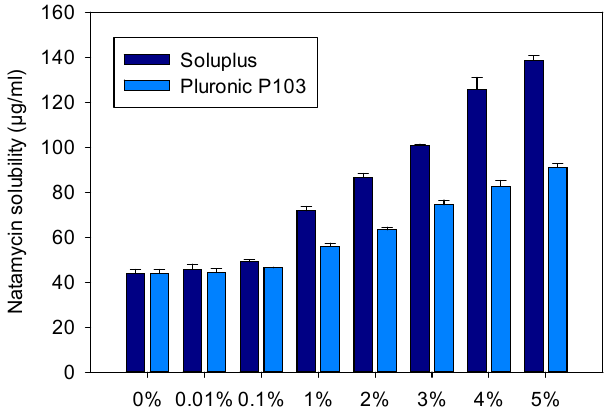
Figure 2. Apparent solubility of natamycin in Soluplus and Pluronic P 103 dispersions (0%, 0.01%, 0.1%, 1%, 2%, 3%, 4%, and 5% w / v ) prepared in 0.9% NaCl at 25 °C.